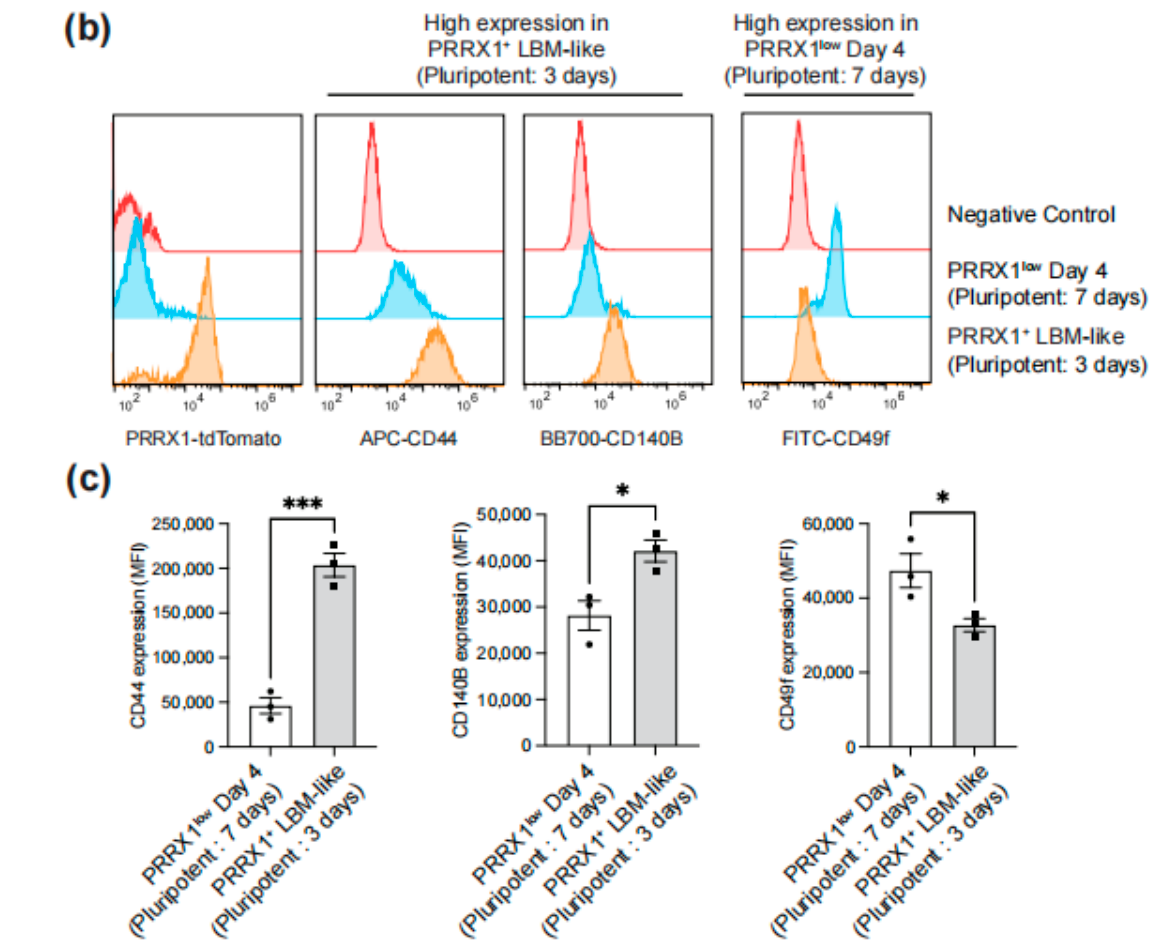
Figure 2. Comparison of surface antigens expressed in PRRX1-tdTomato + LBM-like cells and PRRX1- tdTomato low Day 4 cells. ( a ) Volcano plots to identify genes differentially expressed between PRRX1-tdTomato + LBM-like cells and PRRX1-tdTomato low Day 4 cells. The dashed line indicates the threshold. Red dots represent differentially expressed genes ( n = 2, two biologically independent experiments, padj < 0.01, log 2 FC > 1). ( b ) Representative flow cytometry analysis data for CD44 (HCAM), CD140B (PDGFRB), and CD49f (ITGA6) expressed by PRRX1-tdTomato + LBM-like cells or PRRX1-tdTomato low Day 4 cells. ( c ) Comparison of mean fluorescence intensity (MFI) values of CD44, CD140B or CD49f between Pluripotent: 3 days and Pluripotent: 7 days after LBM-like induction ( n = 3, three biologically independent experiments). * p < 0.05, *** p <